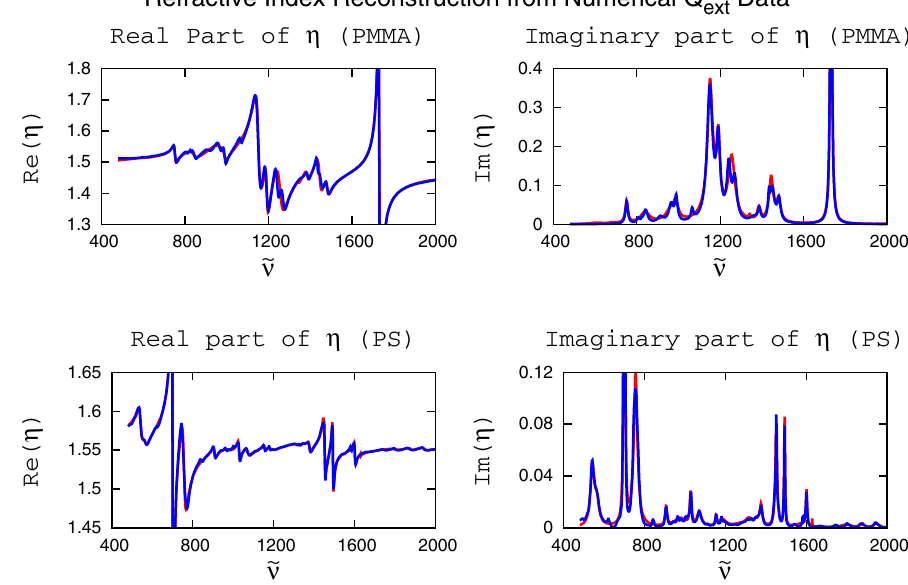
Figure 2. Reconstructions of real parts (left panels) and imaginary parts (right panels) of the complex refractive index η( ˜ ν) of 10 µ m radius spheres, homogeneously filled with PMMA (upper panels) and PS (lower ( given ) ( ˜ ν) . 18 Lorentzians were used for the PMMA panels), using experimental data (blue lines) for obtaining Q ext reconstructions and 22 Lorentzians were used for the PS reconstructions. Although the initial guess of the complex refractive indexes is random, the reconstructions (red lines) are near perfect, indicated by the near perfect overlap of the blue and red